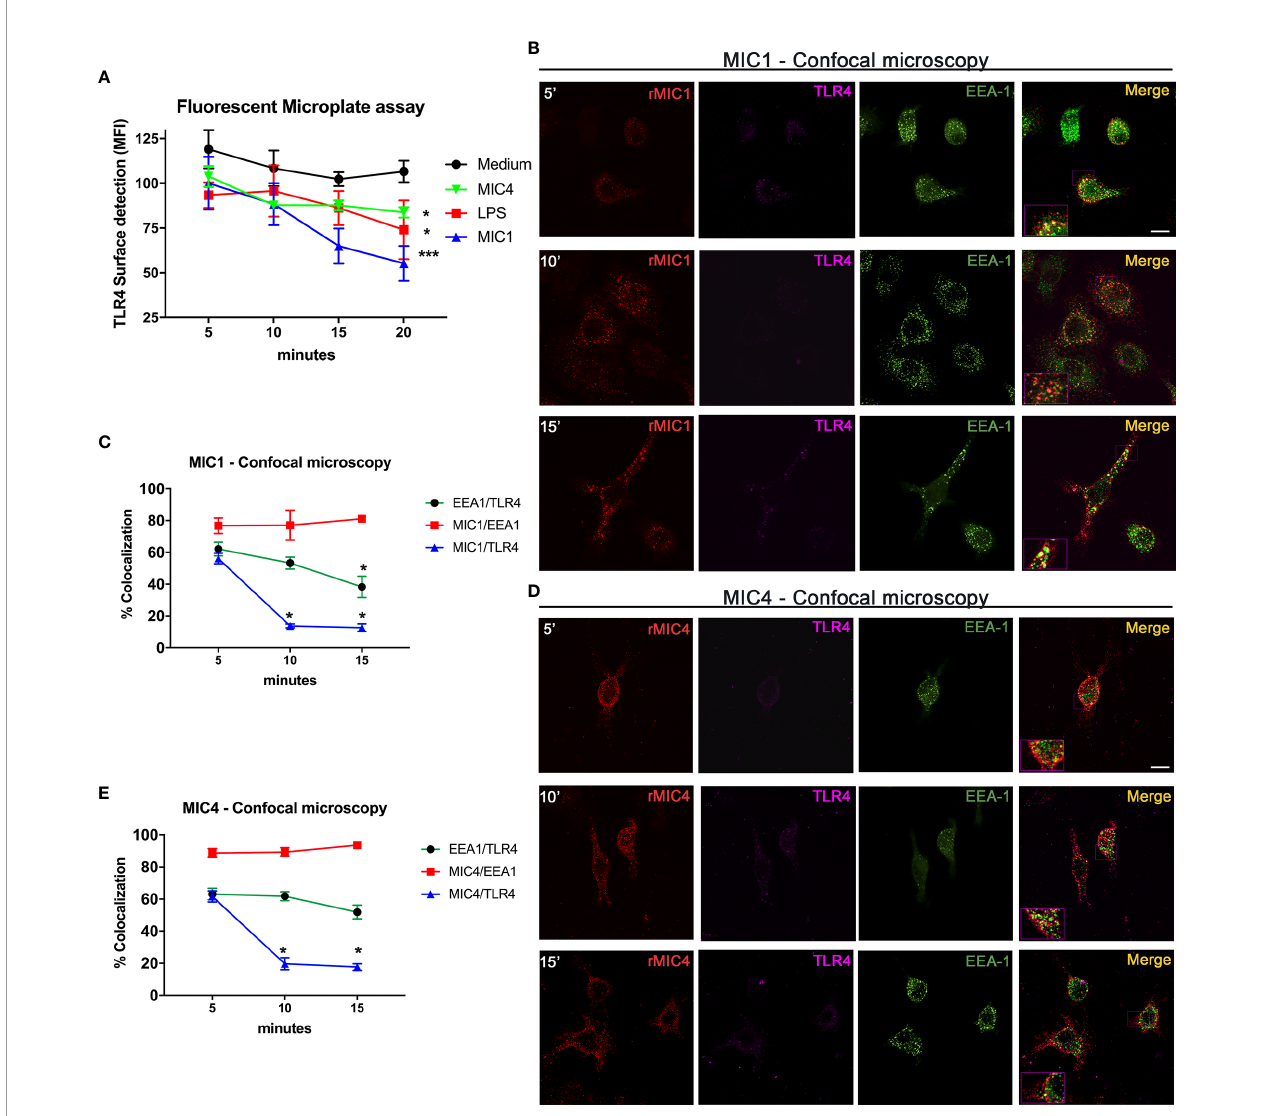
FIGURE 1 | MIC1 and MIC4 colocalize with early endosomes concurrent with TLR4 downregulation on the cell surface. (A) BMDMs were stimulated with medium only, LPS, MIC1, or MIC4 for the indicated periods. After fi xing, cells were blocked (Fcblock) and stained with anti-TLR4 antibodies. Cell surface TLR4 was quanti fi ed using an FLx800 Fluorescence Microplate Reader (BioTek Instruments, USA; excitation 485 nm, emission 528 nm). Results were expressed as MFI + SD. *p < 0.05 and *** p < 0.001 (One-way ANOVA and Bonferroni post-test). For confocal microscopy, BMDMs were incubated with biotin-MIC1 or with biotin-MIC4 for 5, 10, or 15 min (B, D) . After fi xing and permeabilization, cells were immunostained with anti-TLR4 (Alexa-647, pseudo-color -LUT magenta), or anti-EEA-1 (Alexa-488, green). Biotinylated lectins were detected by reaction with fl uorescent streptavidin (Alexa-594, red). Merge = yellow. Bar = 10 m M. Insets: 2.5-fold increased magni fi cation. (C, E) Percentages of colocalization of MIC1 or MIC4 with EEA-1 (red line) or TLR4 (blue line) were determined at 5, 10, and 15 min after stimulation. Additionally, the percentage of EEA1 colocalization with TLR4 was determined (green line) for both MIC1 and MC4 stimulation at the same time points. Results were obtained by calculating the Manders Colocalization Coef fi cient (MCC) and expressed as averages + SD. Representative data from experiments performed in triplicate. *p < 0.05 (one-way ANOVA and Bonferroni